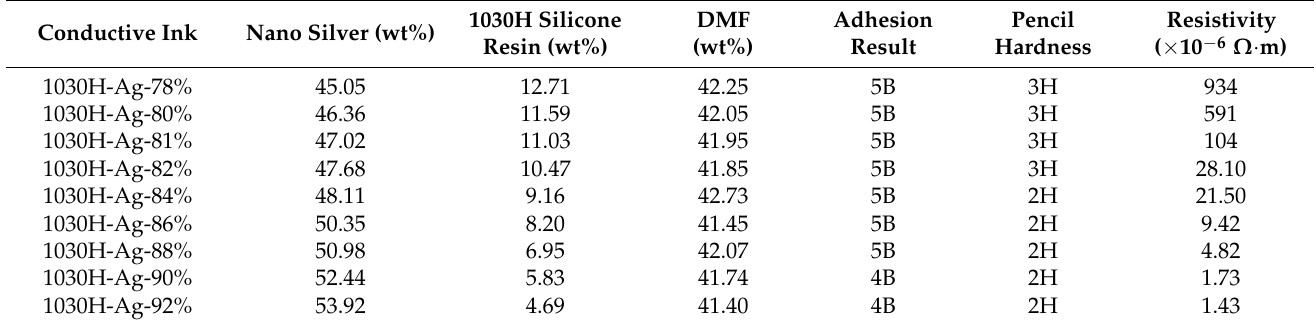
Table 1. Formulations and performance of different silver conductive ink.